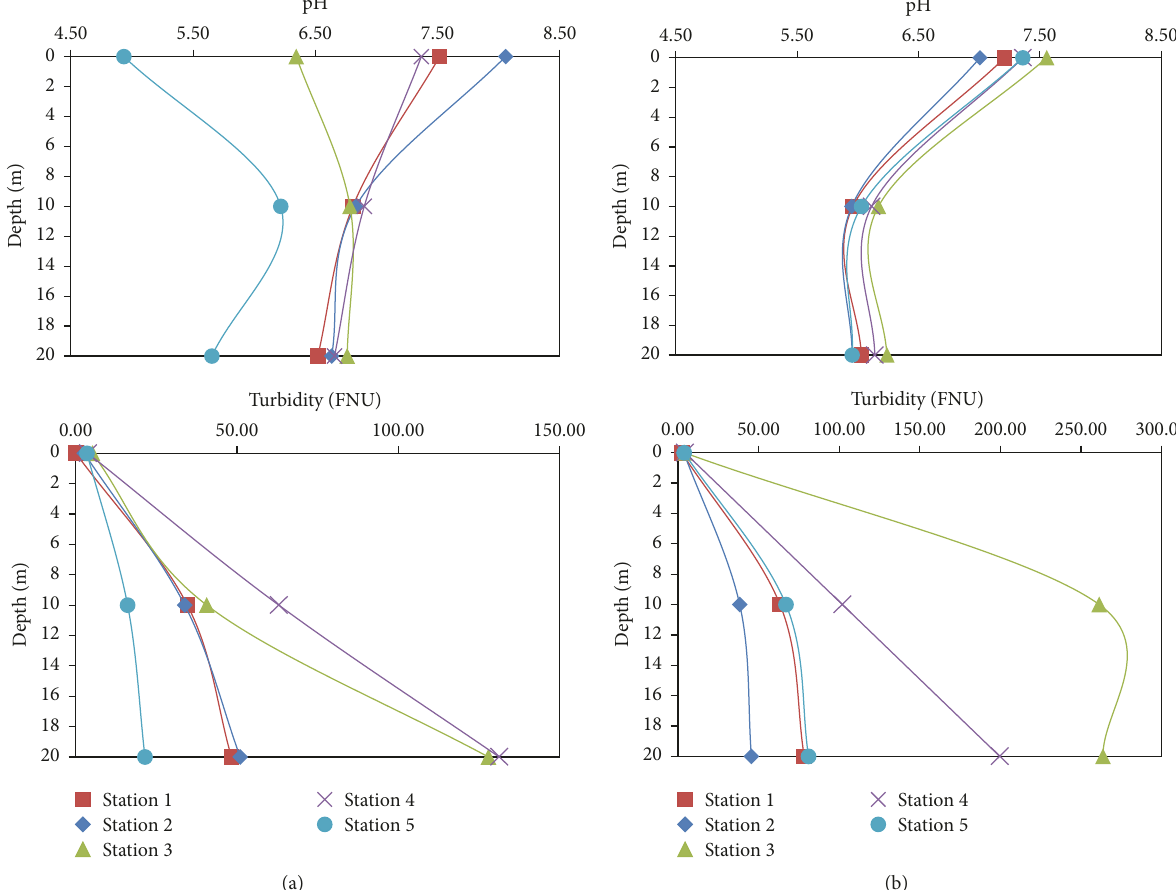
Figure 3: The distribution of pH and turbidity at three different depths (0, 10, and 20m) of Bakun Reservoir in February (a) and September (b)